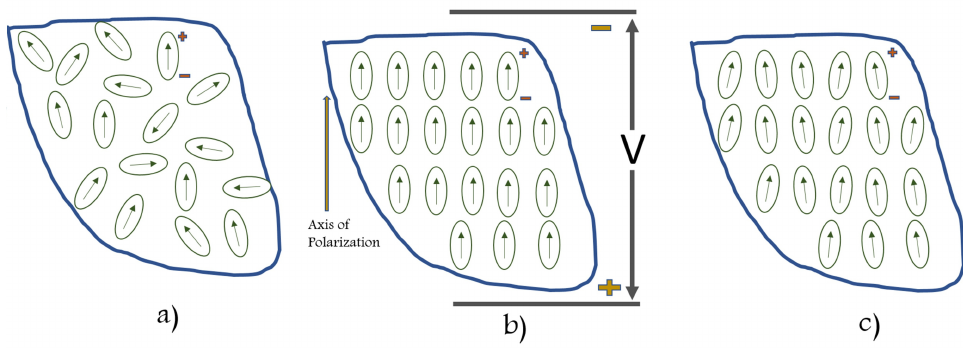
Figure 3. Poling process: ( a ) prior to polarization polar domains are oriented randomly; ( b ) a very large DC electric field is used for polarization; ( c ) after the DC field is removed, the remnant polarization